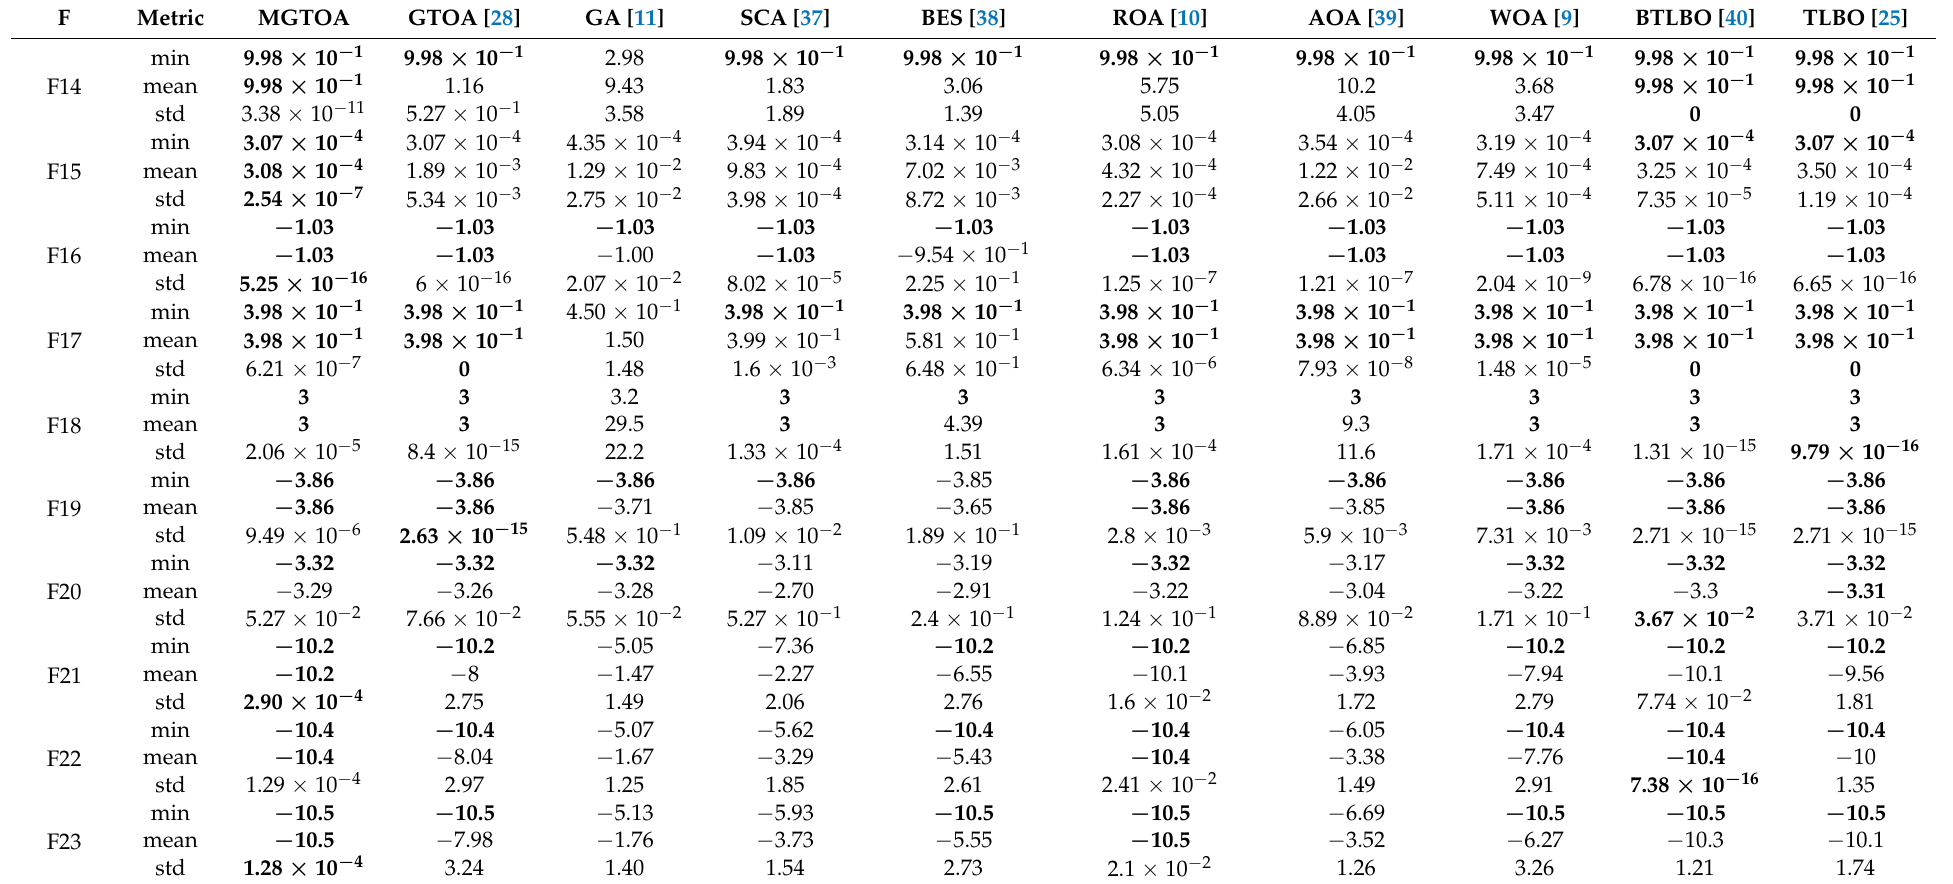
Table 5. Results of benchmark functions